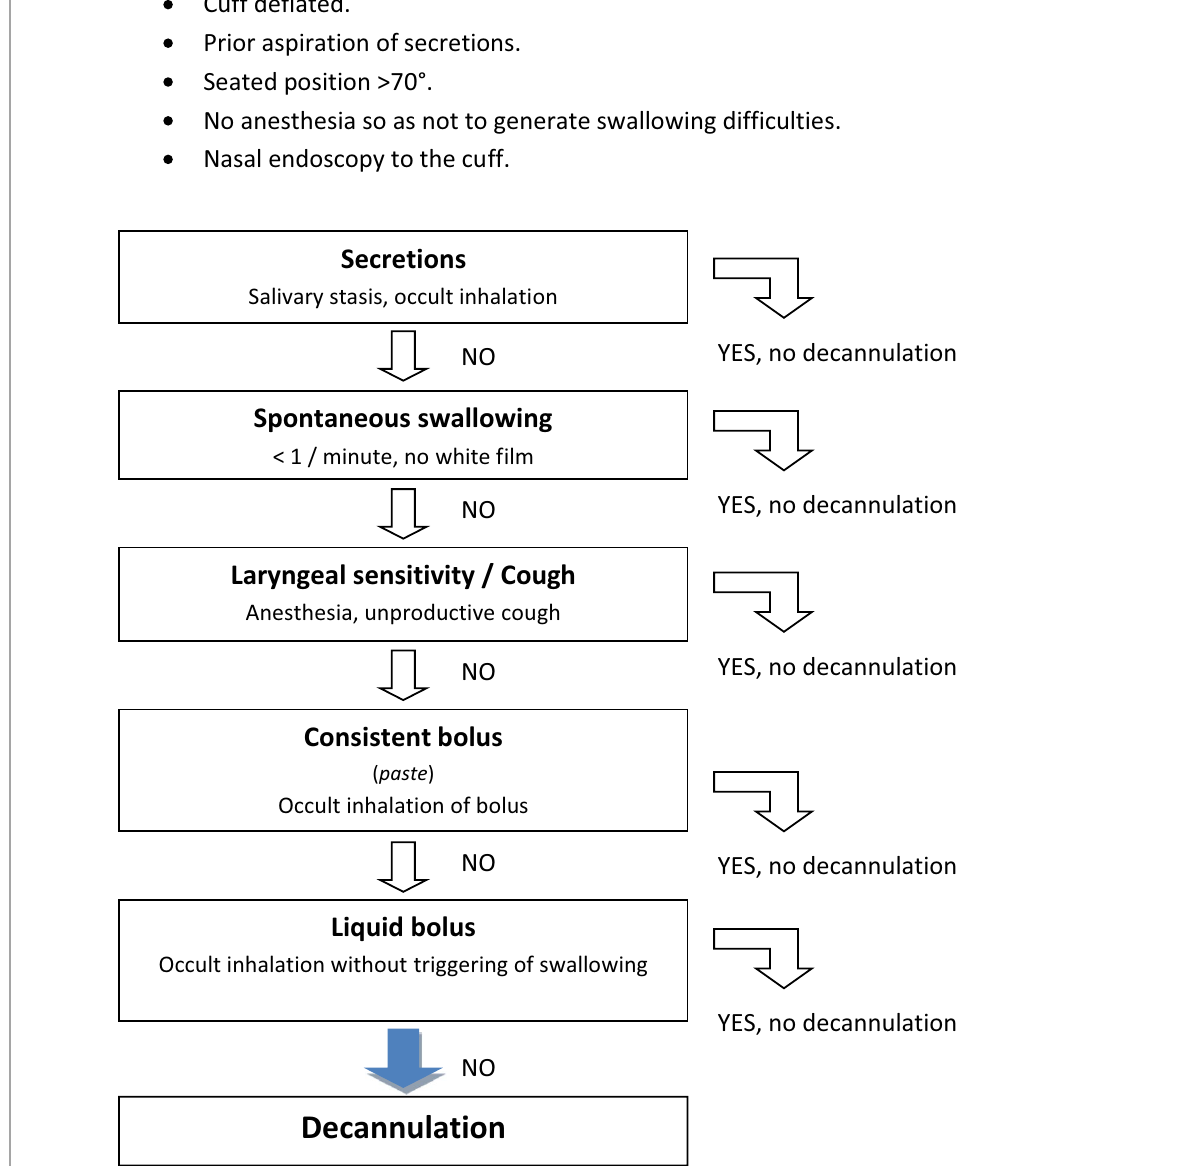
and location of equipment required in cases of respira- tory distress following decannulation.